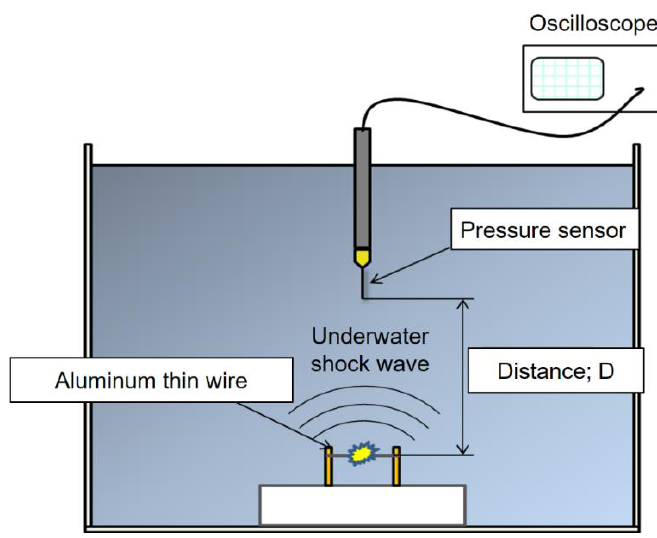
Figure 2. Thyristor for switching.